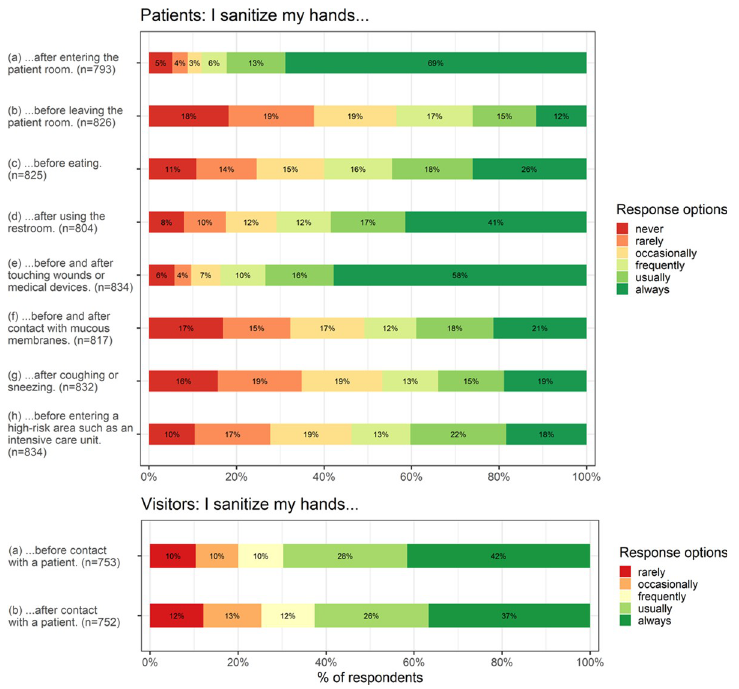
Fig 1. Frequency distribution of self-reported hand hygiene behavior in